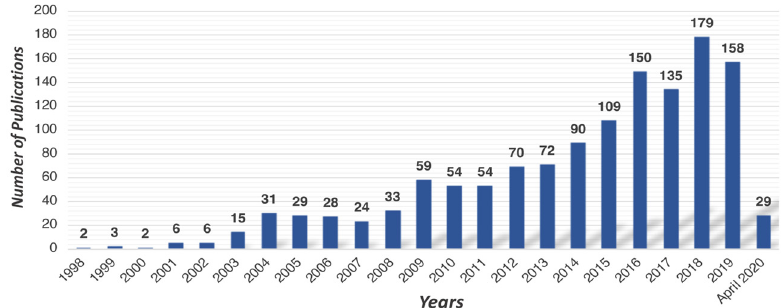
Figure 1. Published literature statistics of urban change detection. The statistics are counted according to the keywords remote sensing and urban change detection from 1998 to April 2020 in Web of Science, acquiring a total of 1283 publications.